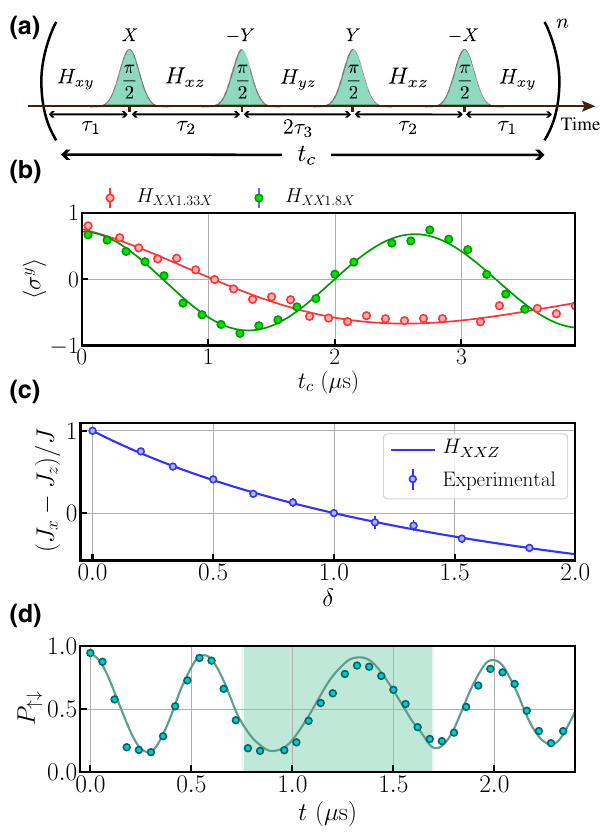
FIG. 1. The implementation of XXZ Hamiltonians with two atoms. (a) The microwave sequence consisting of four π/ 2 Gaus- sian pulses driving rotations around the X , − Y , Y , and − X axes. (b) The evolution of the y magnetization under H driven after ini- as a function of t c , for two ratios τ 1 /τ 2 tialization in |→→(cid:2) y corresponding to δ = 1.33 and 1.8. The lines are fitted to the data. (c) The normalized oscillation frequency of the y magne- tization as a function of δ . The circles show experimental results (error bars from the fits of the oscillations), while the solid line shows the prediction from Eq. (4) with no adjustable parame- ters. (d) The evolution of the probability P ↑↓ under H XXZ and H XXX (green shaded region), following the preparation in |↑↓(cid:2) . The solid lines show the simulation using the XXZ Hamiltonian. (b),(d) The error bars represent the standard error of the mean, which is often smaller than the symbol